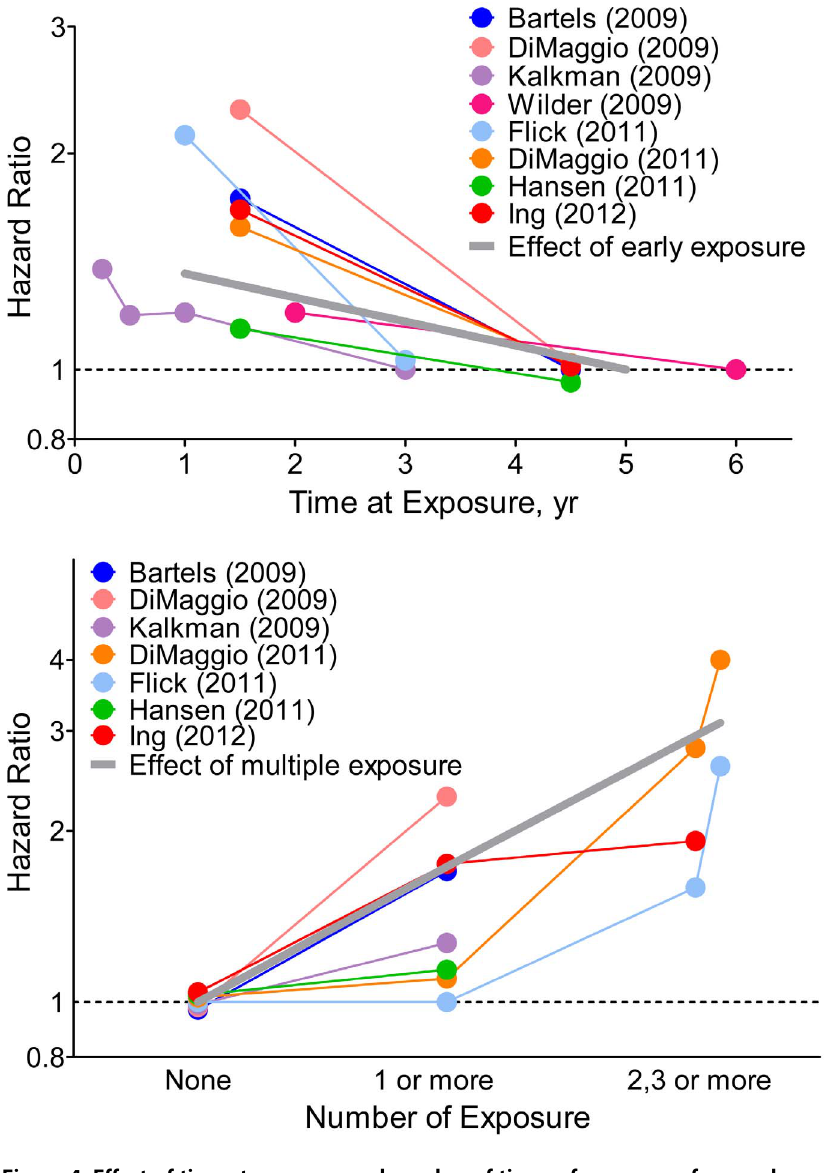
Figure 4. Effect of time at exposure and number of times of exposure of general anesthesia on neurodevelopment in children. A. Relationship between categories of time at exposure and hazard ratio (HR) of later neurodevelopmental deficits in each analytical group. The line for each individual study is located over the range of time at exposure. The gray thick line indicates the effect of time at exposure (per 1-year early) on neurodevelopmental deficits using a meta-regression analysis. The slope of gray line represents the change in the log HR per 1-year early. The vertical axis is on a log scale. The result of effect of number of times of exposure on neurodevelopmental deficits is shown in B. The gray thick line indicates the effect of number of times of exposure on neurodevelopmental